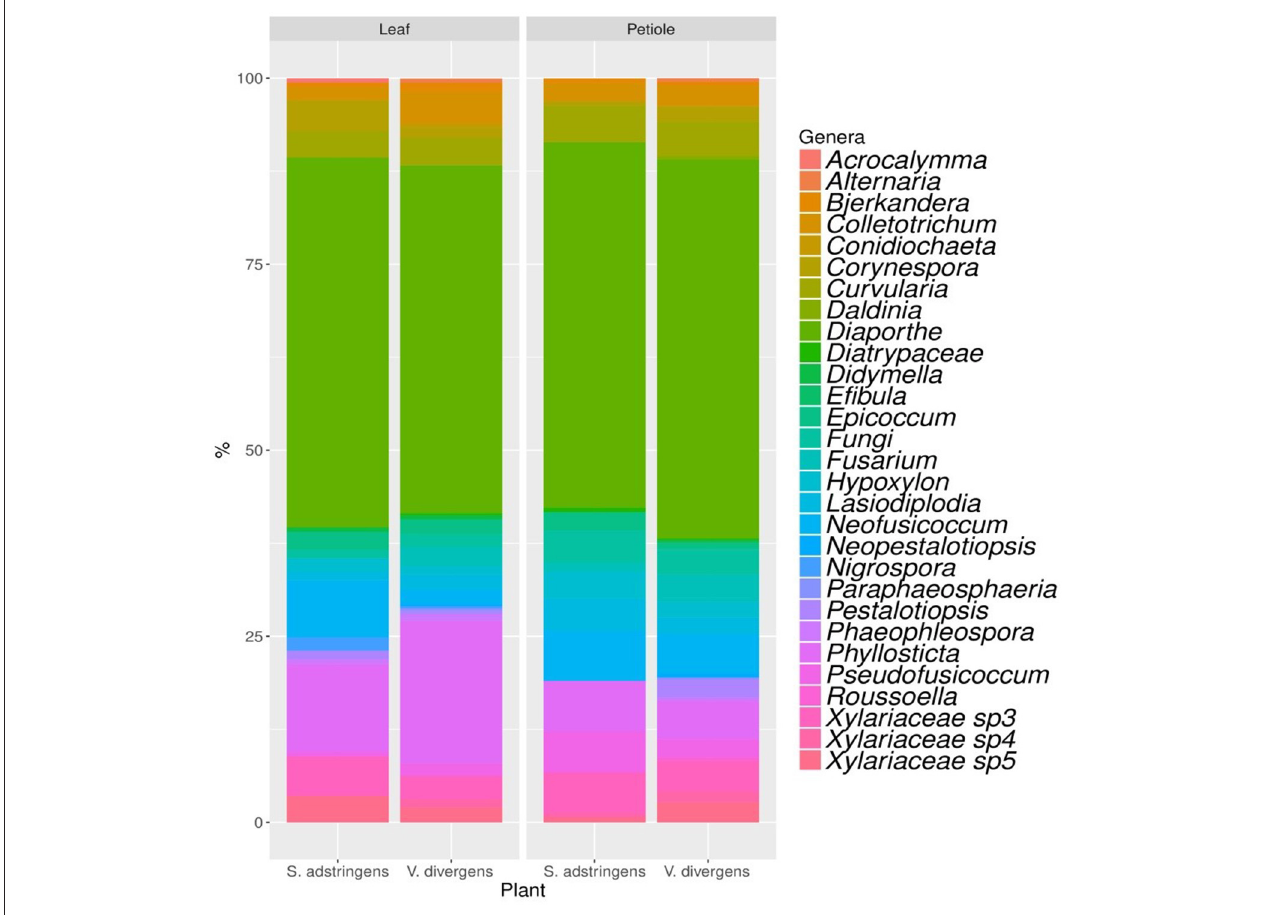
FIGURE 3 | Genera composition of endophytic community obtained from petioles and leaves of Stryphnodendron adstringens and Vochysia divergens